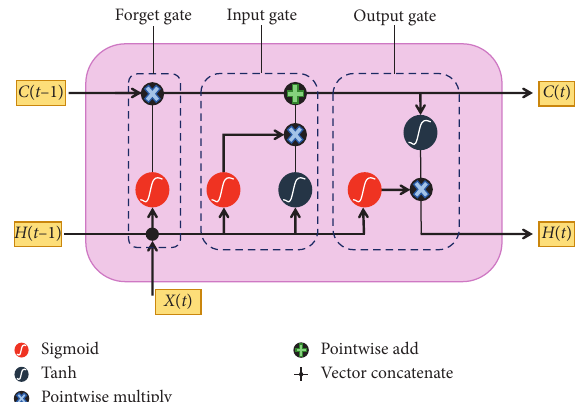
Figure 4: Internal neuron structure of long- and short-term memory neural network